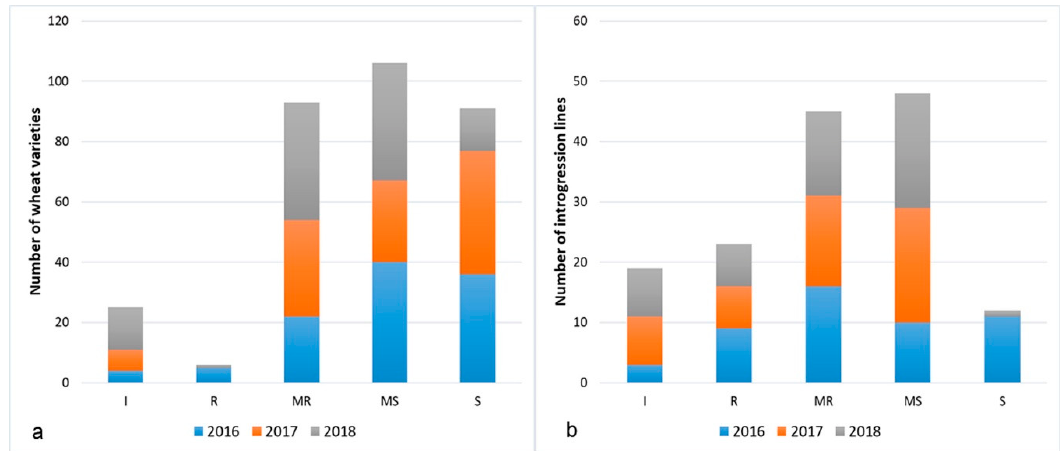
Figure 2. Frequencies of wheat varieties ( a ) and introgression lines ( b ) in different infection types to stem rust pathogen.